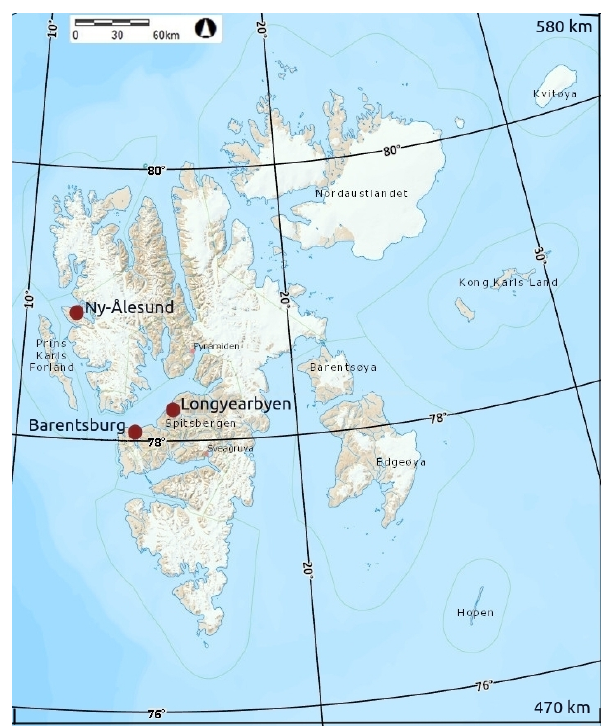
Figure 1. Map of Svalbard with three settlements where the NO x were measured in spring 2017. The map is made using the online tool https://toposvalbard.npolar.no/ (last access: 14 July 2022), pro- vided by the Norwegian Polar